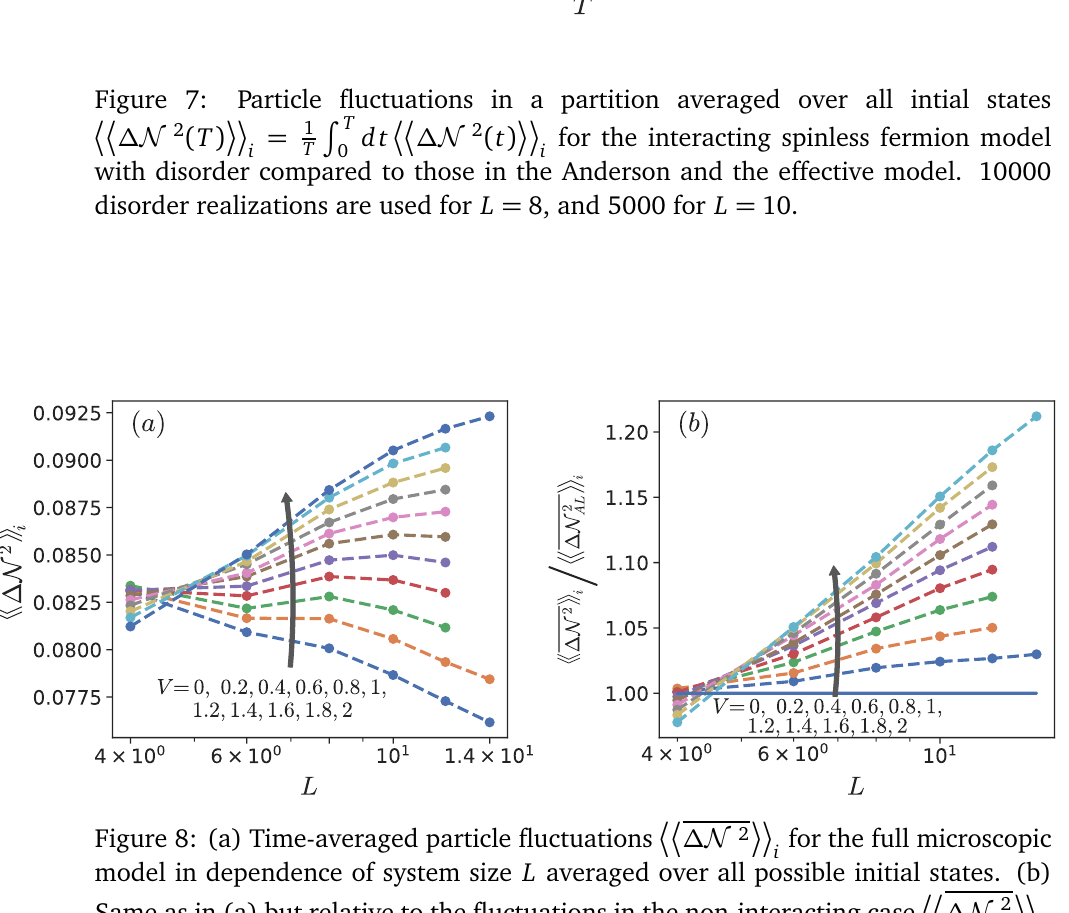
Figure 8: (a) Time-averaged particle fluctuations model in dependence of system size L averaged over all possible initial states. (b) Same as in (a) but relative to the fluctuations in the non-interacting case The data are averaged over 10000 disorder